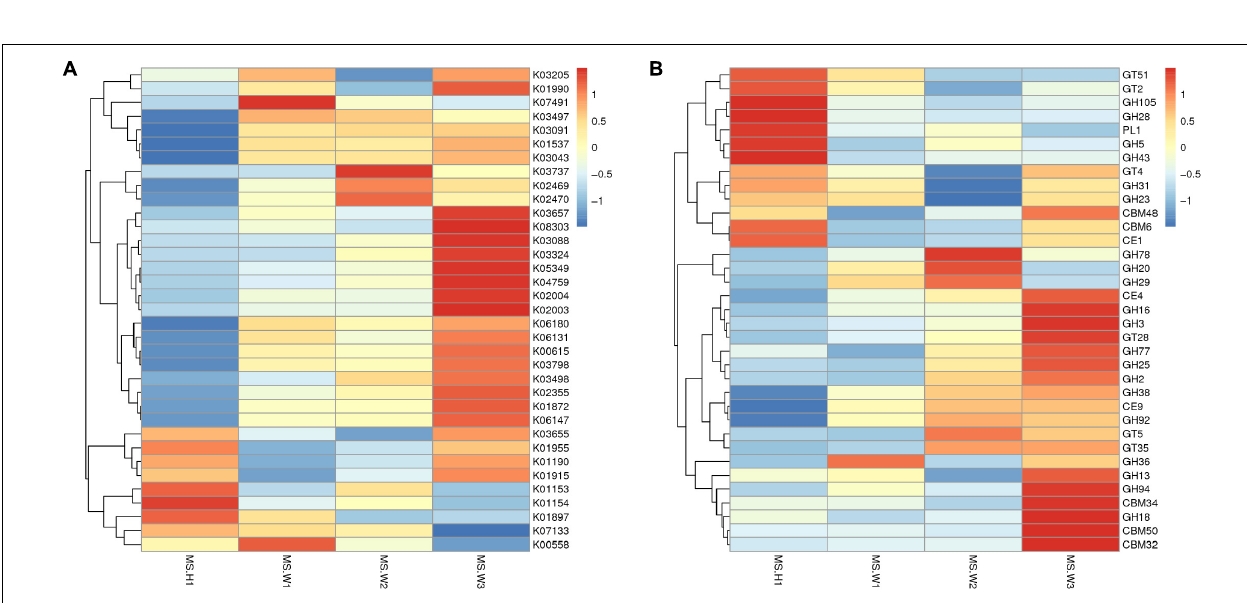
FIGURE 4 | Differences in the functional profiles of fecal microbiomes in the two musk deer populations (normalized by Z -score across all datasets). KEGG and CEs that showed the largest differences, in proportional representation, between CG and WG populations. (A) Heat map of the top 35 functions based on the KEGG database. (B) Heat map of the top 35 functions based on the CAZy